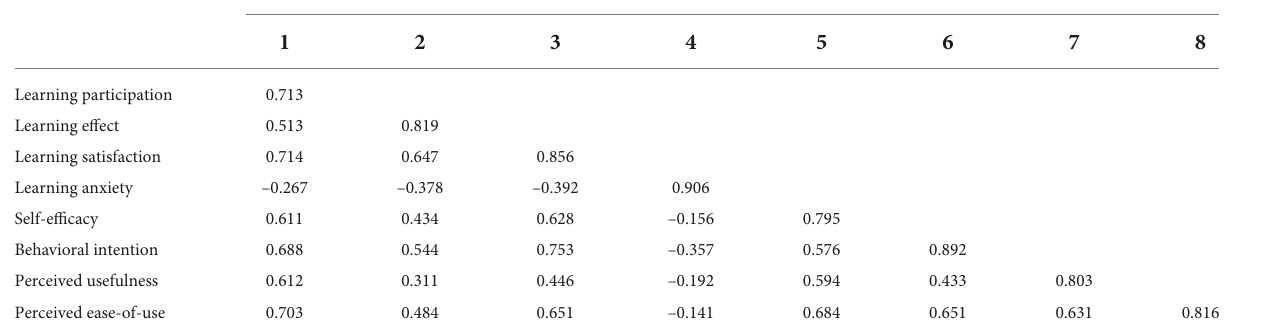
TABLE 4 Reliability analysis of all dimensions in the SPOC-AIOT